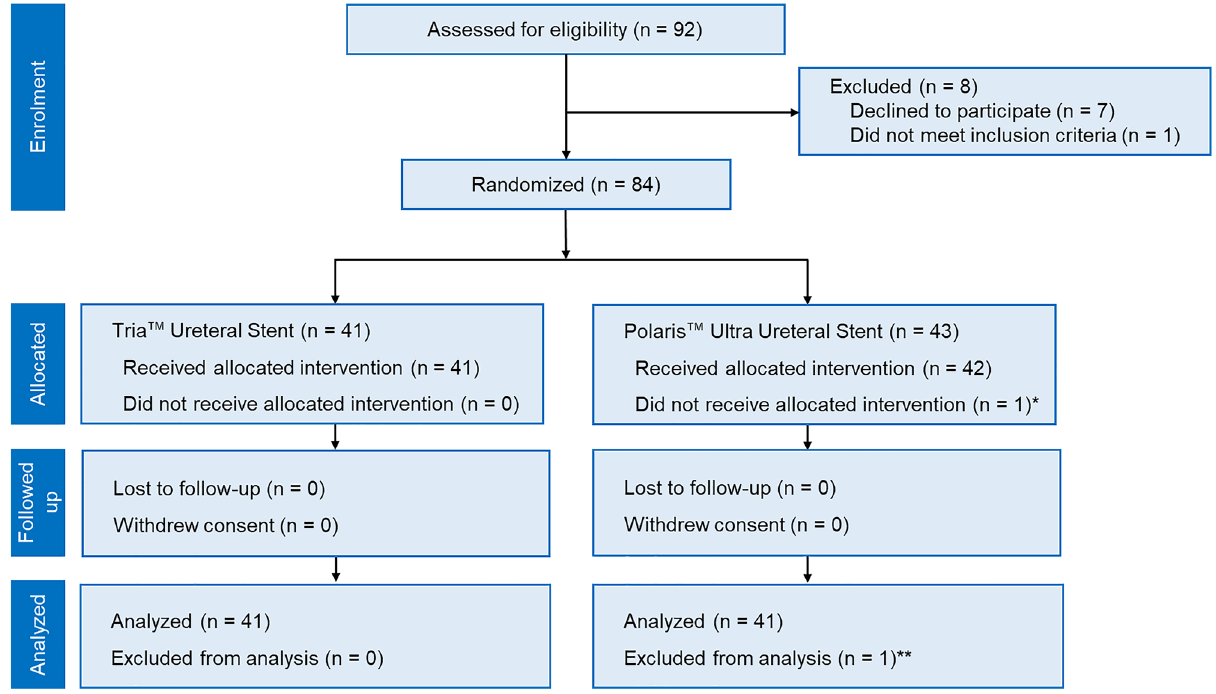
Figure 1. CONSORT diagram of the study. The symbol * Indicates that surgery was not performed due to anaphylaxis. The symbol ** Indicates that the stent was discarded